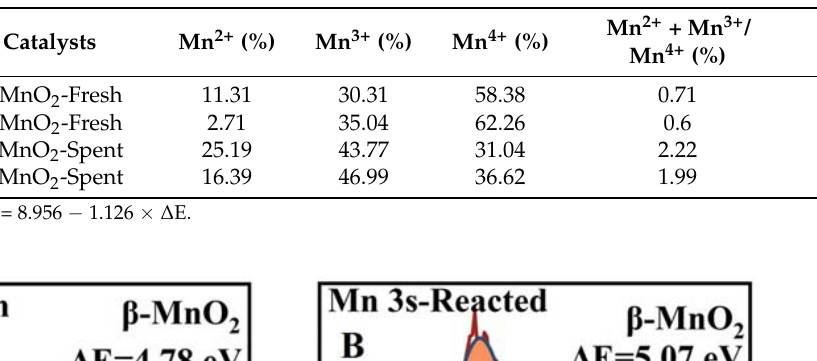
Table 1. Mn 3s Mn 2p 3/2 results before and after the reaction of B-MnO 2 and C-MnO 2 .